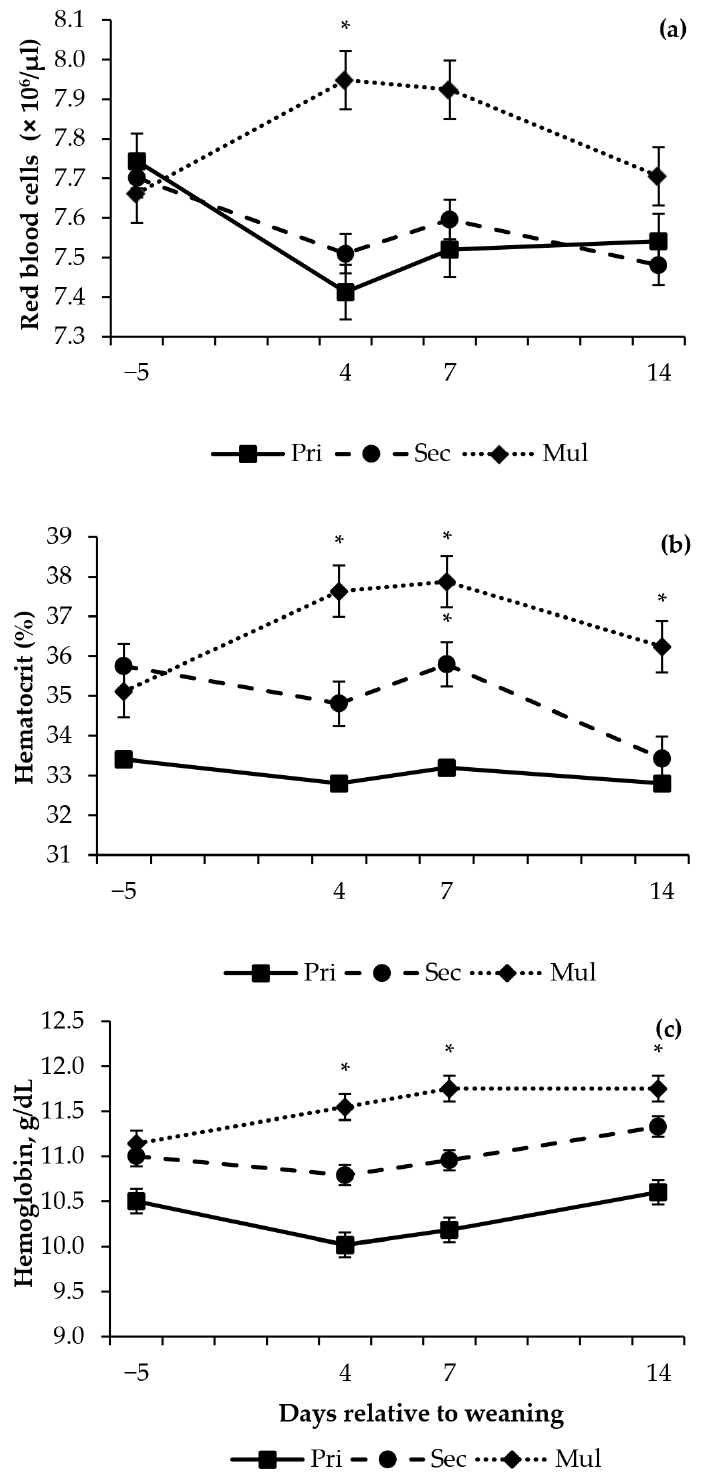
Figure 4. Red blood cell number (RBC; ( a )), Hematocrit percentage (HCT; ( b )), and hemoglobin concentration (HB; ( c )) in Nellore cows with different parity under grazing according to the days relative to weaning. On days with asterisks (*) there is a parity x day interaction ( p < 0.05). In addition, effects of day relative to weaning were detected for WBC counts and lymphocyte and neutrophil numbers (Table 2). All cows had lower WBC counts after weaning ( p < 0.0001; SEM = 0.76; Figure 5a). Lymphocyte numbers decreased on d +4 and d +7 and increased again on d +14 ( p = 0.004; SEM = 0.54; Figure 5b). Neutrophil numbers were also lower on d +4 ( p = 0.006; SEM = 0.23; Figure 5c). Nonetheless, the N:L ratio was not a ff ected by parity, day, or parity and day ( p > 0.05; Table 2).